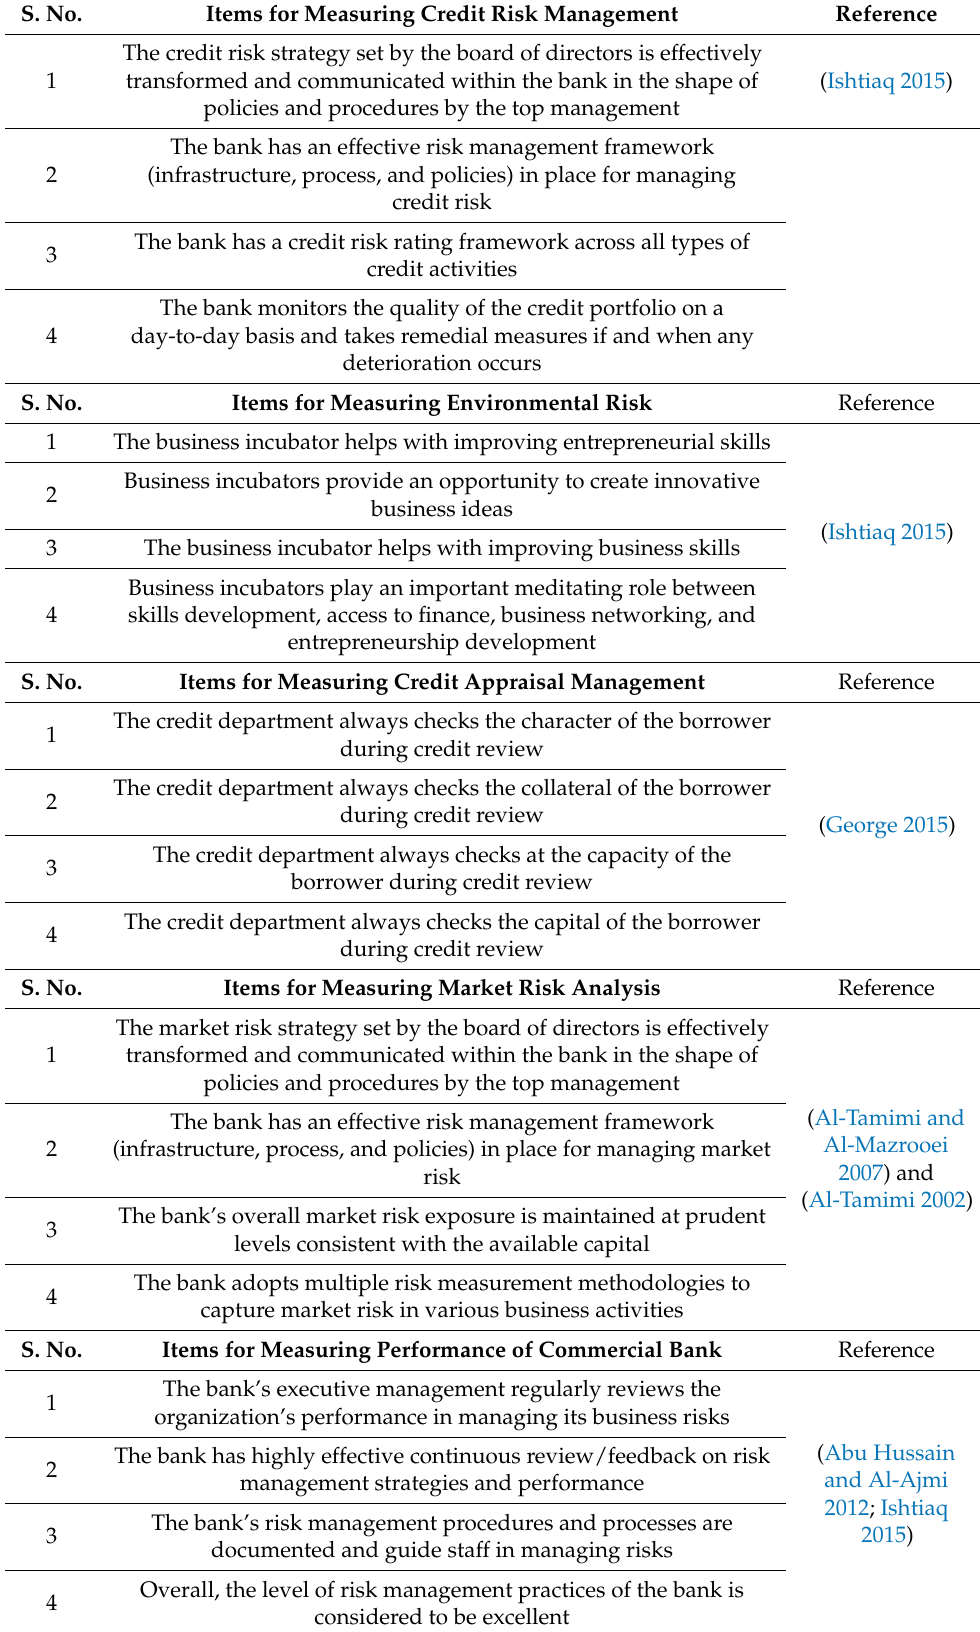
Table 1. Description of measurement